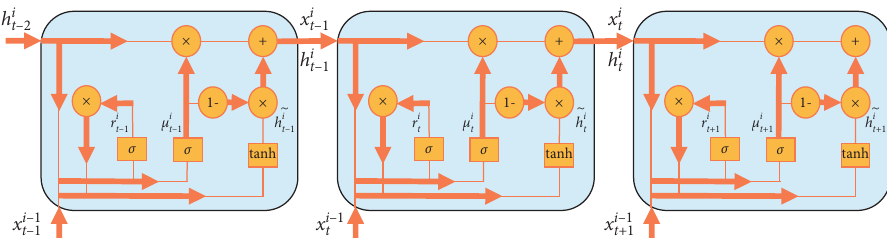
Figure 2: Recurrent convolution layer gate control mechanism.